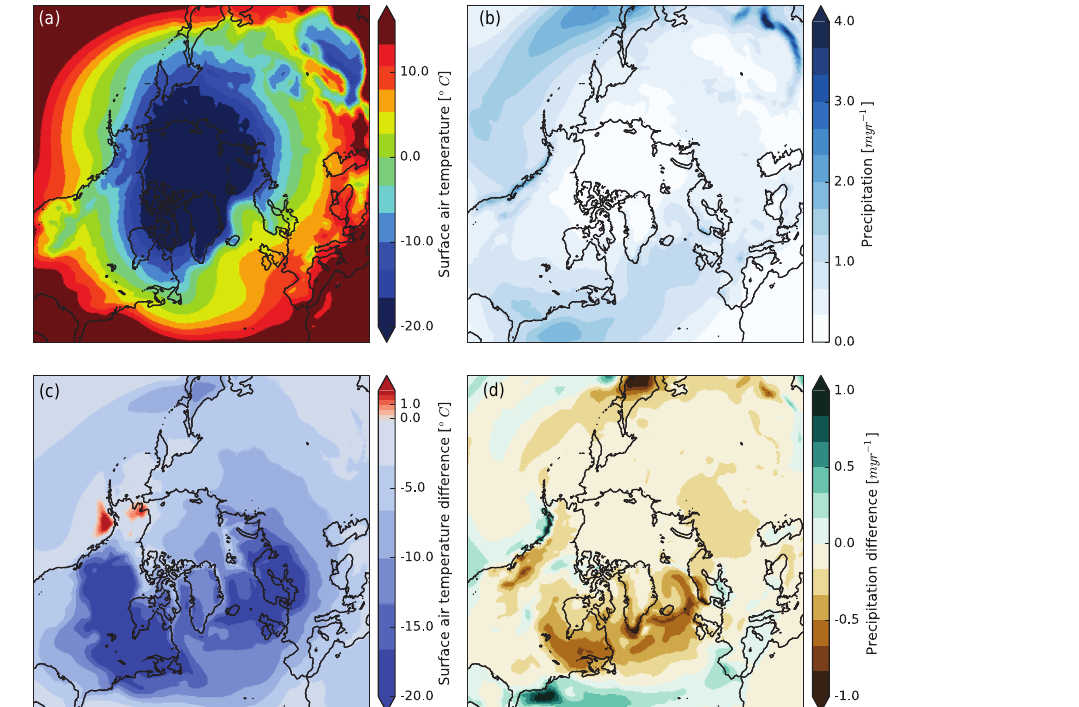
Figure 2. Annual mean surface air temperature (a) and total annual precipitation (b) of the preindustrial (PI) climate forcing from CCSM4. The anomalies of the LGM climate forcing with respect to PI (LGM − PI) are shown in (c) and (d) . No correction for surface elevation or temperature bias has been applied